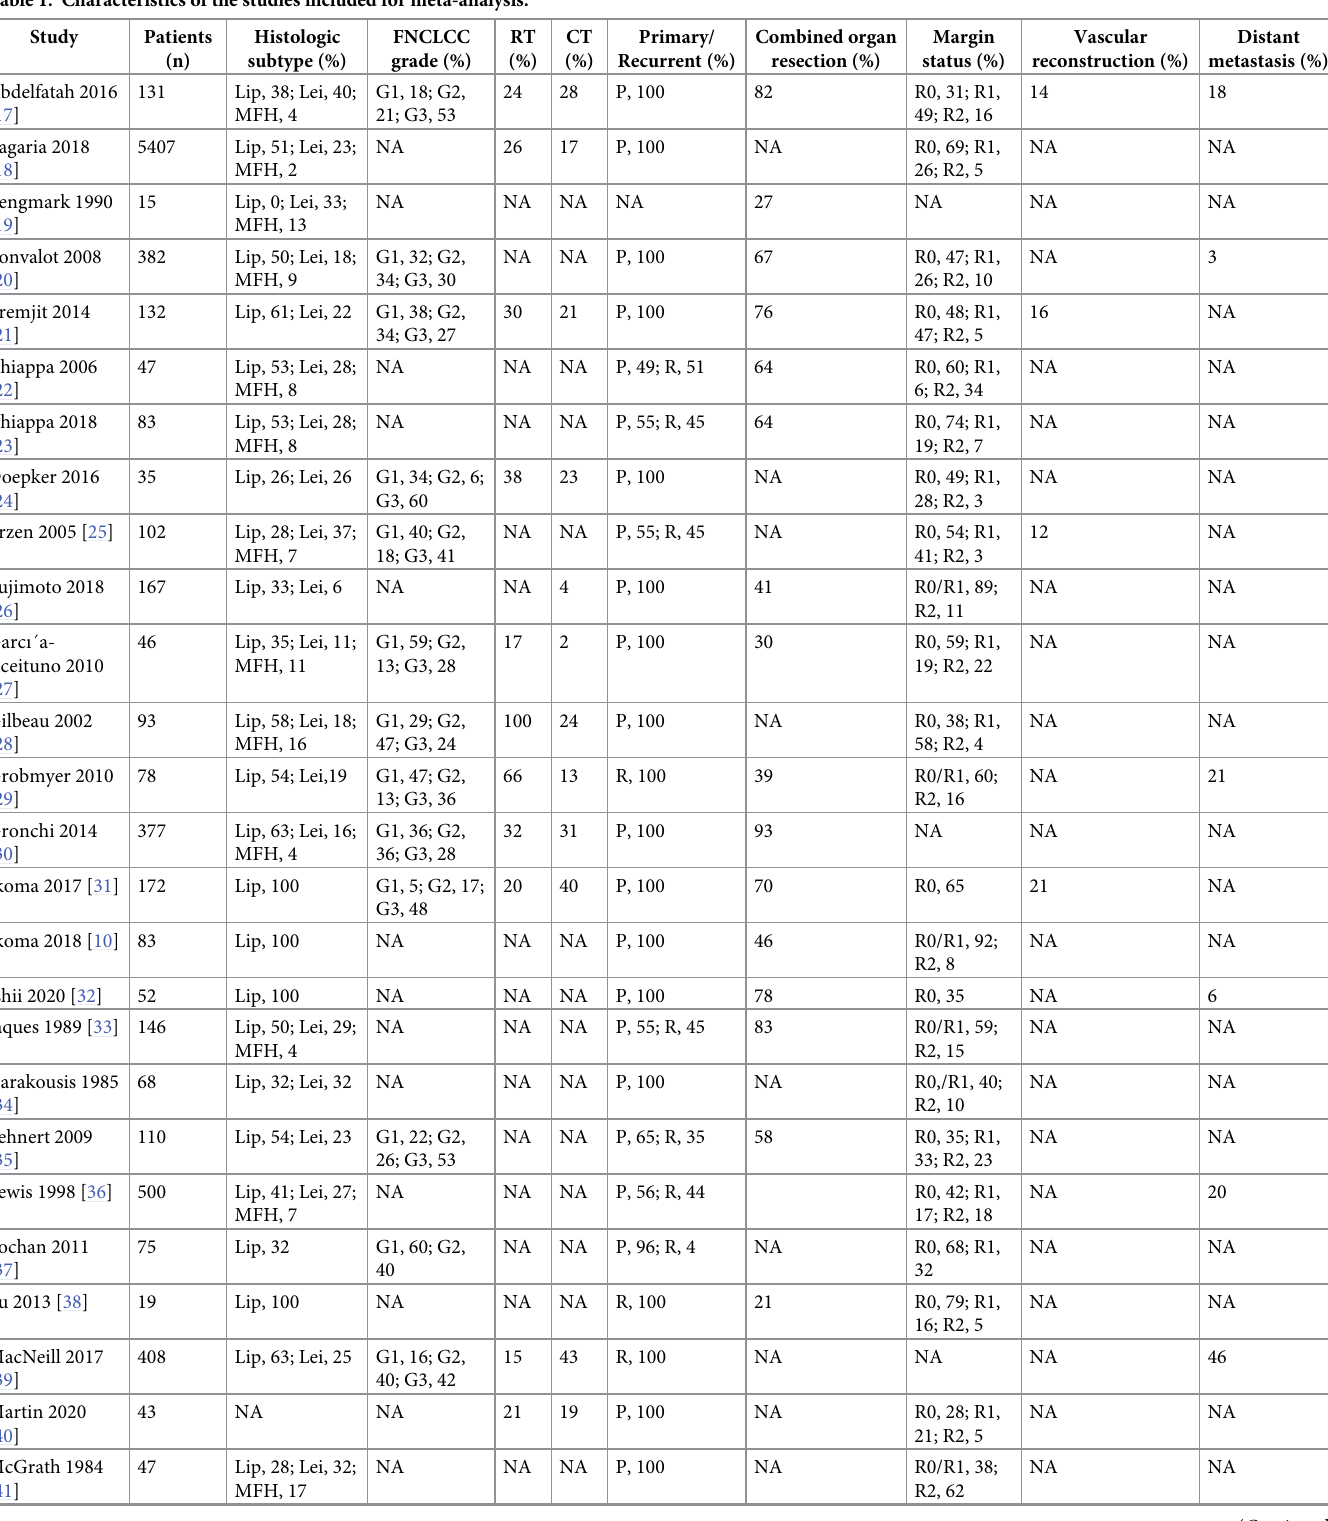
Table 1. Characteristics of the studies included for meta-analysis.